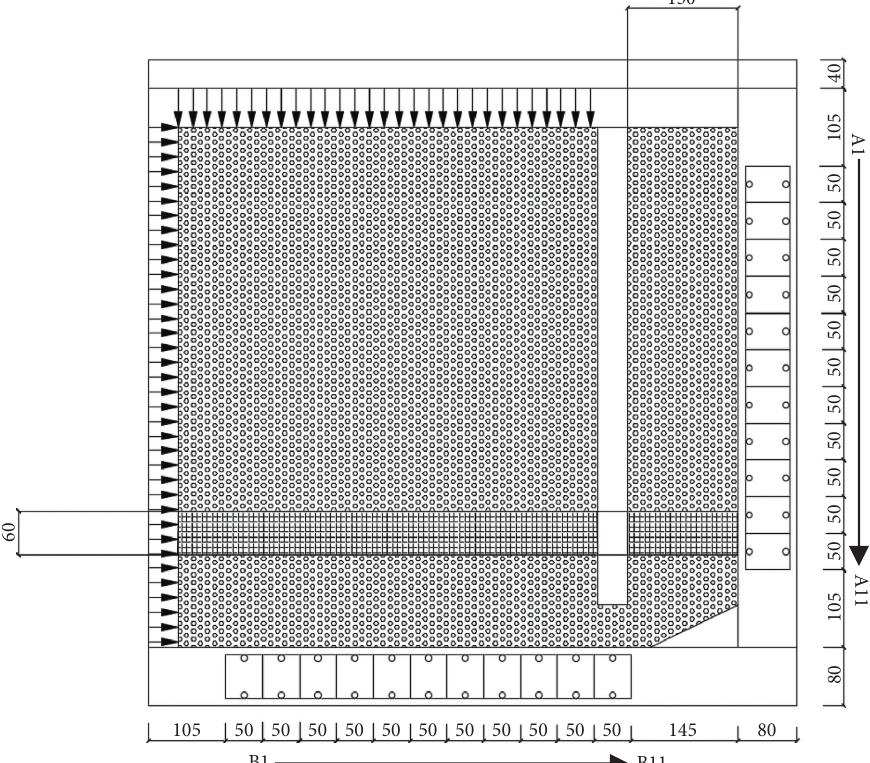
Figure 5: Illustration of the photoelastic